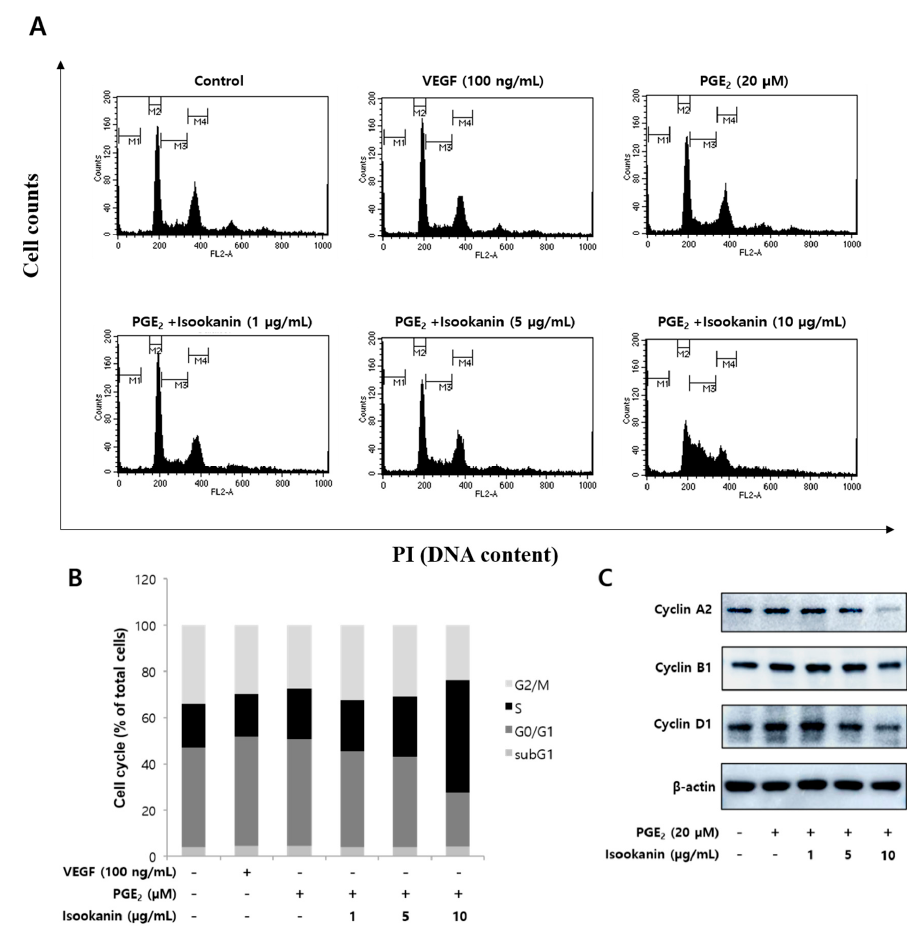
Figure 5. Effects of isookanin on the regulation of cell cycle and the expression level of cell cycle regulatory proteins on PGE 2 -induced HMEC-1 cells. Cells were pretreated with the indicated concentrations of isookanin for 2 h before stimulation with PGE 2 (20 µ M). ( A ) Total DNAs were labeled with propidium iodide and analyzed by flow cytometry. ( B ) The cell cycle distribution was analyzed with BD CellQuest™ Pro Software. ( C ) Cell cycle-related proteins (Cyclin A 2 , Cyclin B 1, Cyclin D 1 ) and β -actin (a loading control) were analyzed by Western blotting. 2.6. Effects of Isookanin on Phophorylation of ERK1/2 and CREB in PGE 2 -Induced HMEC-1 Cells Mitogen-activated protein kinase (MAPK) pathways constitute a large modular net- work that regulates a variety of physiological processes, including cell growth and differ- entiation. Extracellular signal regulated kinases (ERK1/2) are responsible for stimulating numerous downstream effectors, many of which are transcription factors [33]. Cyclic adenosine monophosphate (cAMP) response element-binding protein (CREB), is one of the transcription factors that plays an important role in cell proliferation and the cell cycle [34]. To characterize whether isookanin acts on the PGE 2 -mediated angiogenesis signaling pathway, activation of ERK1/2 and CREB was investigated. Figure 6 shows that the phos- phorylation of ERK1/2 and CREB was induced by PGE 2 (20 µM), and phosphorylation of both ERK1/2 and CREB was inhibited by isookanin. These results indicate that isookanin